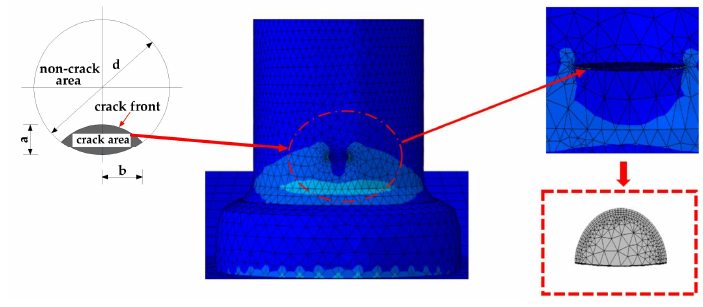
Figure 19. Initial crack characteristics.